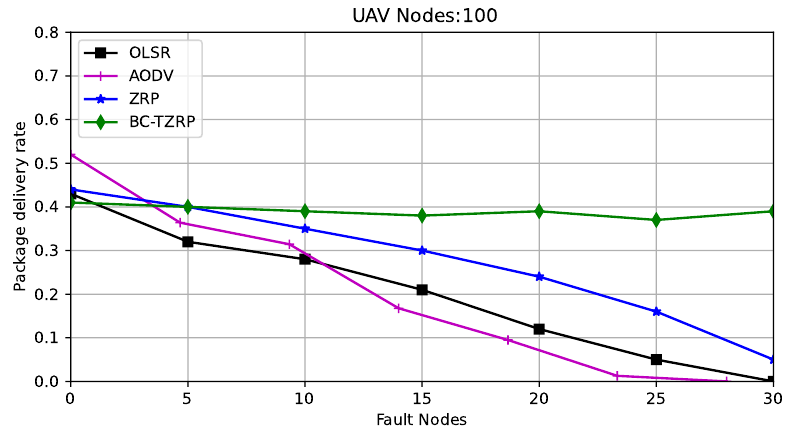
Figure 4. Packet delivery rate for a progressively increasing number of fault nodes. Routing Overhead: The routing overhead is the number of routing control packets sent out by all nodes in the same condition. Figure 5 shows the status of routing overhead for each routing protocol under different error nodes. In the absence of errant nodes, both ZRP and AODV have low routing overhead and OLSR has the highest routing overhead, but as errant nodes appear the overhead of OLSR, AODV and ZRP increases rapidly and OLSR is the first to crash as the routing overhead exhausts the radio bandwidth, but BC_TZRP stays at a low level and shows a continuous downward trend due to the isolation of untrustworthy nodes. For the same reason, erroneous nodes generate a lot of invalid routing information, leading to an increase in the routing overhead of classical routing protocols, whereas the nodes involved in route construction and maintenance in BC_TZRP are trusted, avoiding the interference of invalid routing information, and the routing overhead remains largely unchanged.